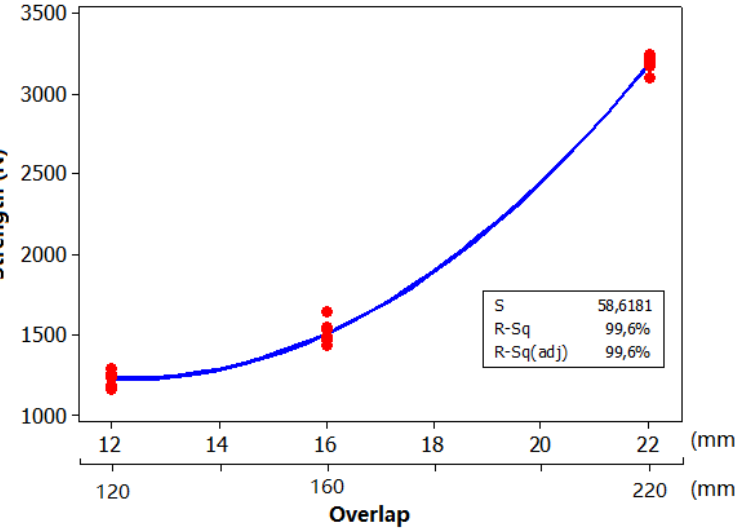
Figure 9. Adhesive strength of the PPCF and PP composite plotted as regression functions of the overlap area (48, 64, and 88 mm 2 ).